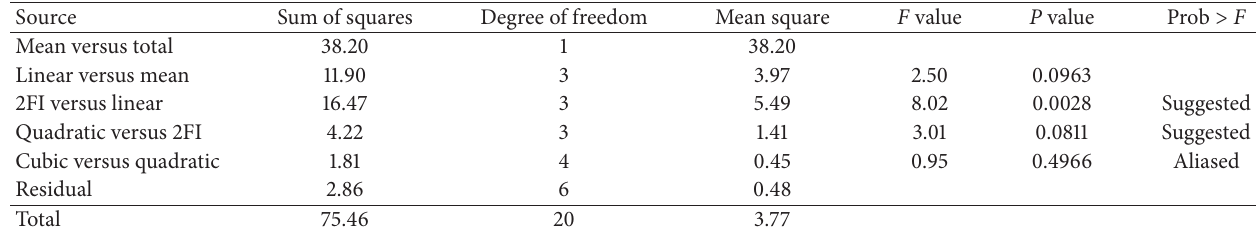
Table 4: Model fit summary for ADI specific activity.